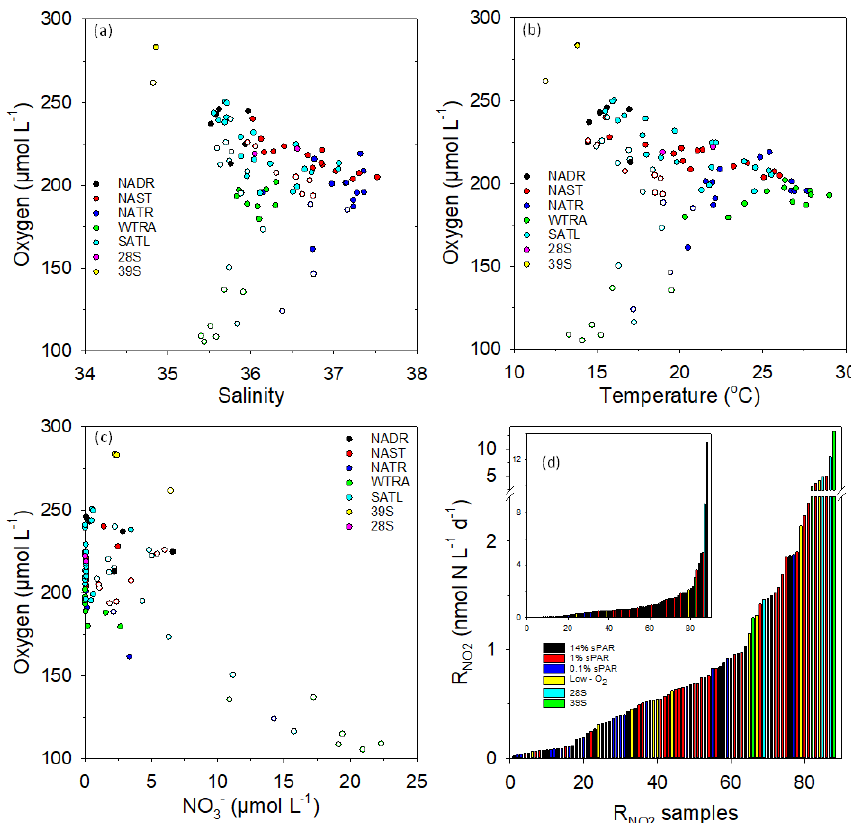
Figure 4. Plots of dissolved oxygen concentration vs. salinity (a) , temperature (b) , and NO − (c) within Longhurst provinces (defined in 3 Fig. 1). Open circles represent 0.1% sPAR data, highlighting distinct characteristics associated with specific NATR/WTRA/SATL sampling points. To represent the distribution of rate data, the 88 R NO measurements were arranged in ascending order ( d , insert has linear scale) 2 with an indication of sampling depth or the association with a specific feature (low oxygen, defined as < 150µmolL − 1 or mesoscale eddy). Measurements within eddy features tend towards the high end of the scale, as do measurements at 1% sPAR. Low-oxygen measurements show no clear distributional trend, while 14% and 0.1% sPAR values tend towards the low end of the